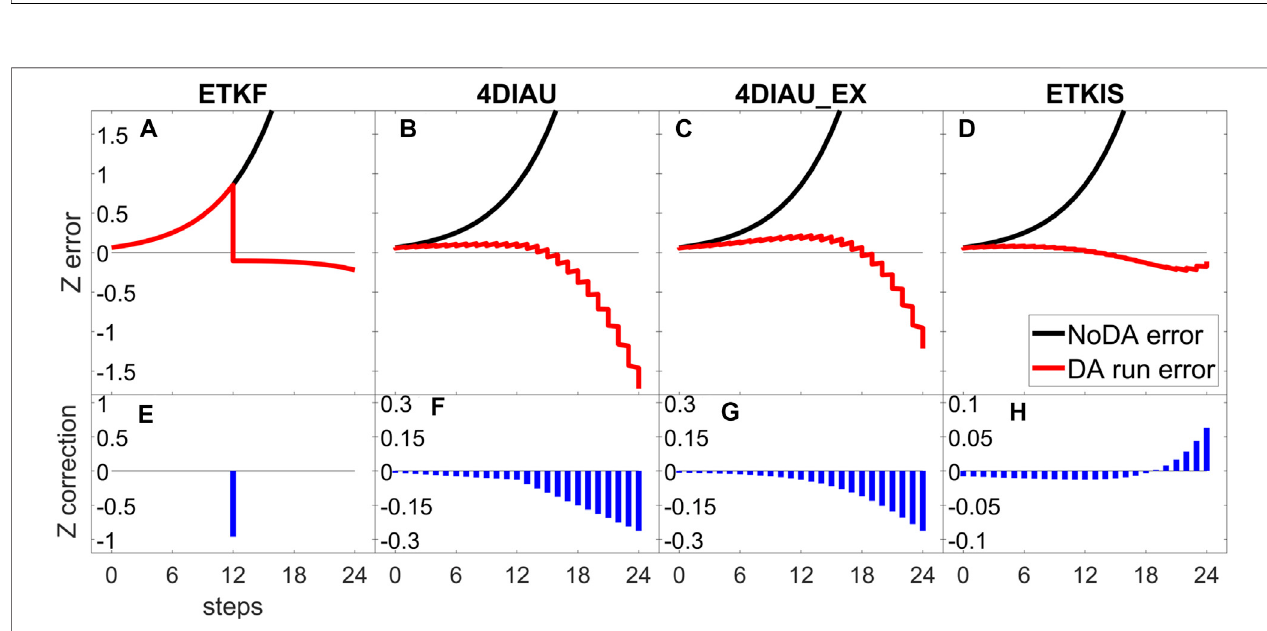
FIGURE6| Theerrorandincrementduringthe316thDAcycleintheof fl inecyclingexperimentfortheETKF,ETKIS,4DIAU,and4DIAU_EX.Theupperpanel (A – D) shows the error evolution of the z variable: the black line indicates how the error grows without correction, and the red line indicates how the error evolves after applying the analysis increment. The lower panel shows the (E) analysis increment and (F – H) gradual increment of the z variable.